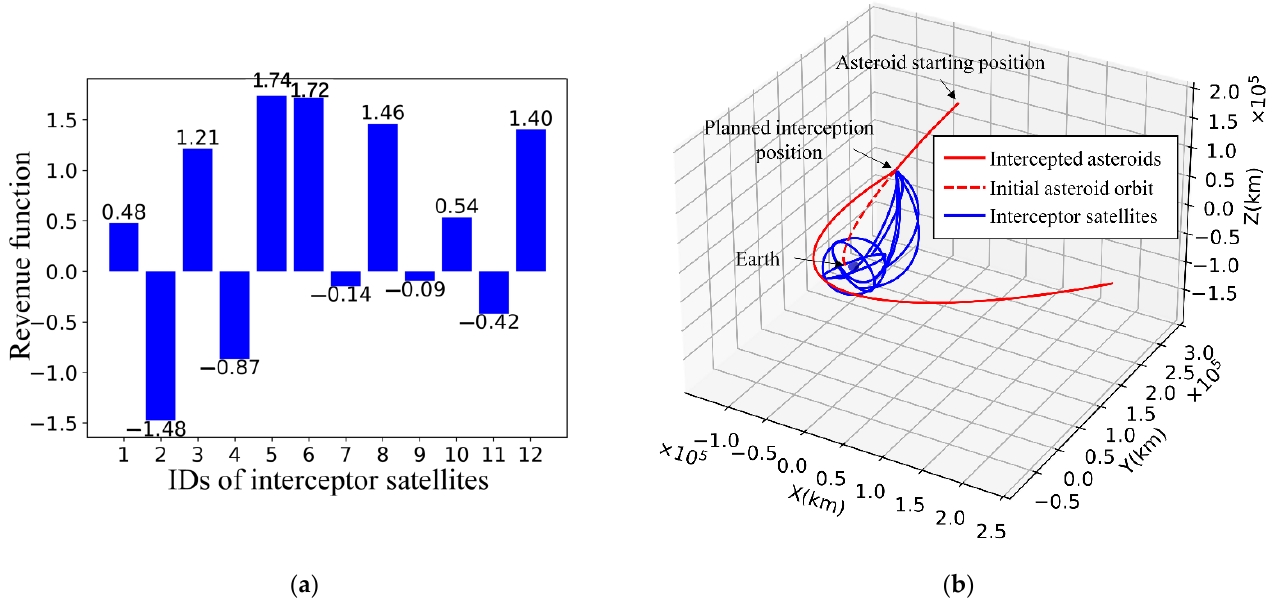
Figure 8. Simulation results when t i = 120,000 s. ( a ) Revenue function. ( b ) Total trajectory diagram. (3) Defence task allocation and interception orbit planning when t i = 160, 200